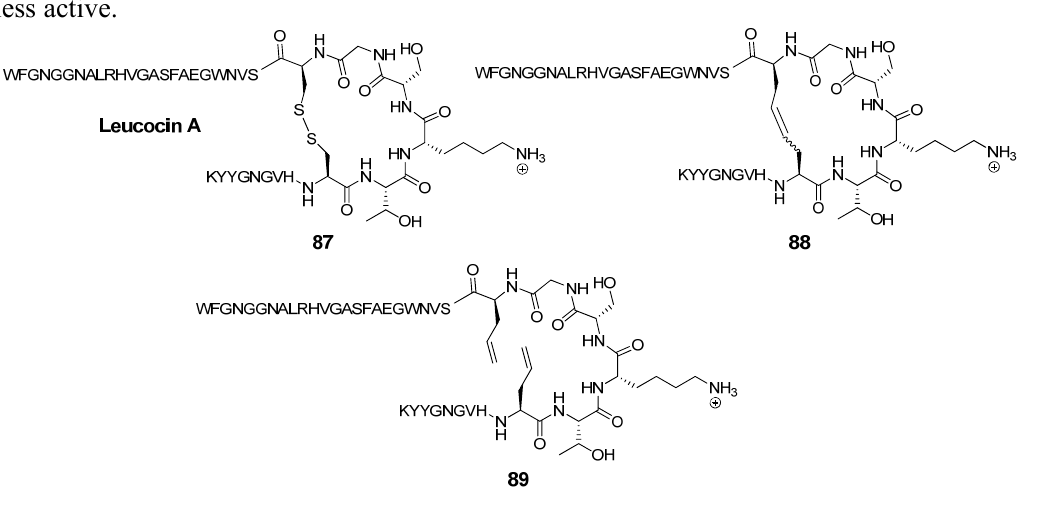
Figure 23. Surprisingly, the diolefinic precursor 89 is nearly as potent against